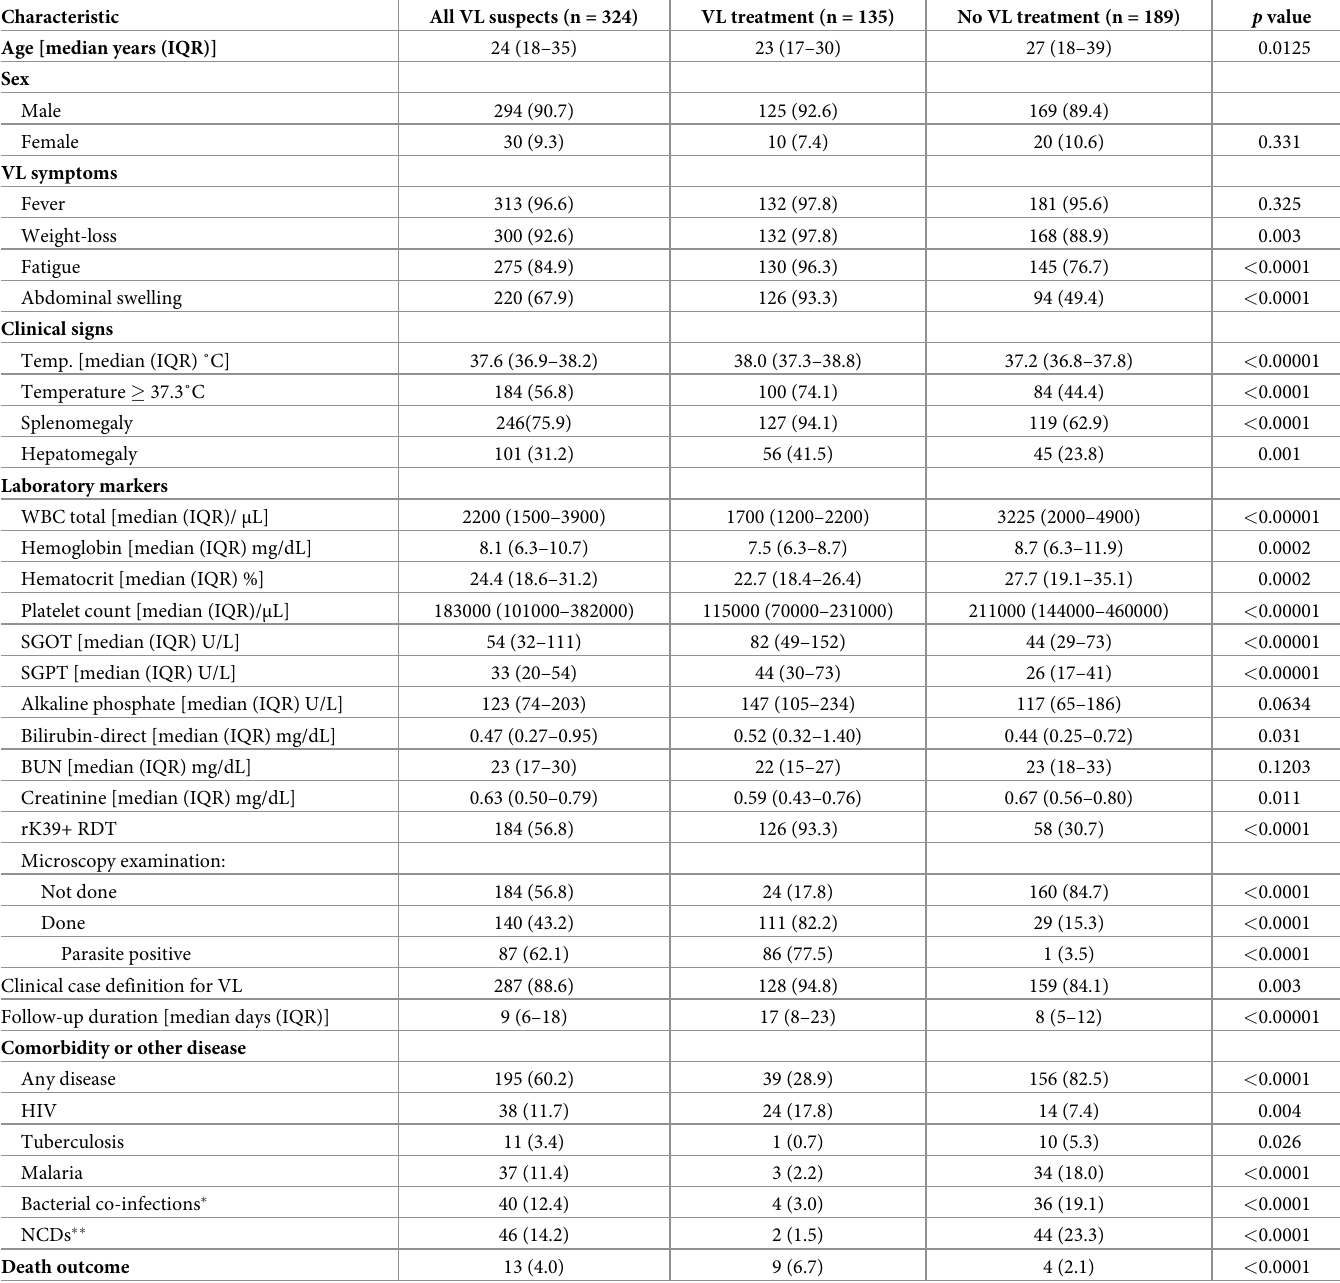
Table 1. Characteristics of the study population stratified by visceral leishmaniasis (VL) treatment status.